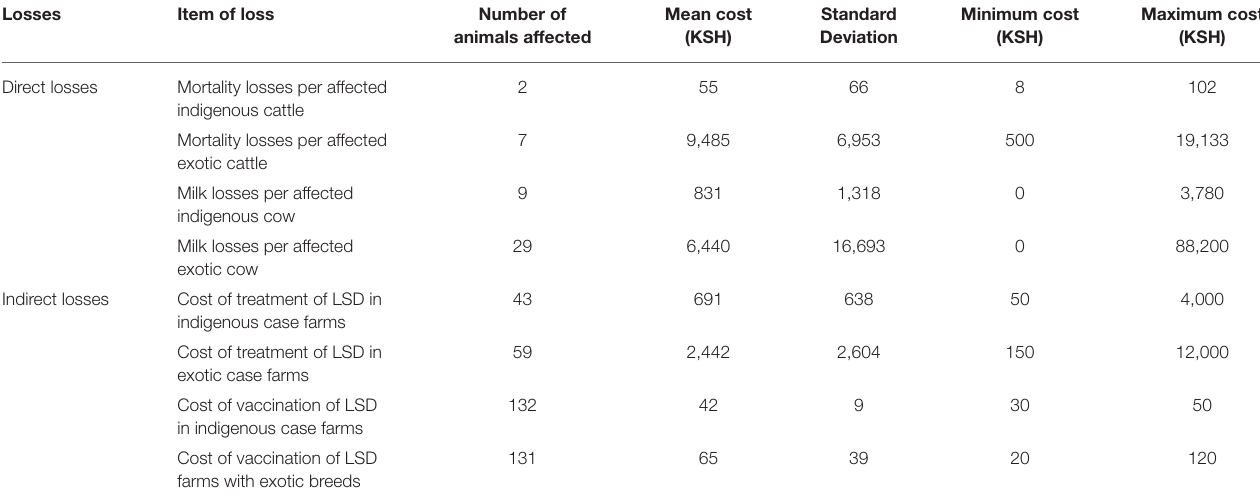
TABLE 4 | Losses incurred by farms due to LSD outbreak in Nakuru County (1 USD = 101 KSH; two farms having mixed breeds were excluded in this analysis) per head of cattle.